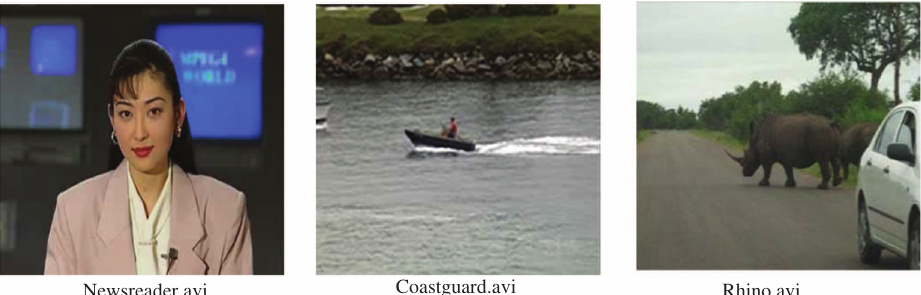
Figure 4: The Videos Dataset Used for Evaluating the Proposed